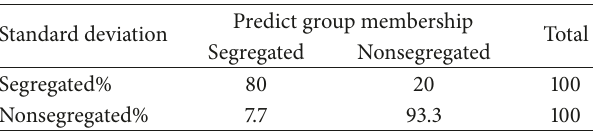
Table 1: Classification results a , b for site location 1.